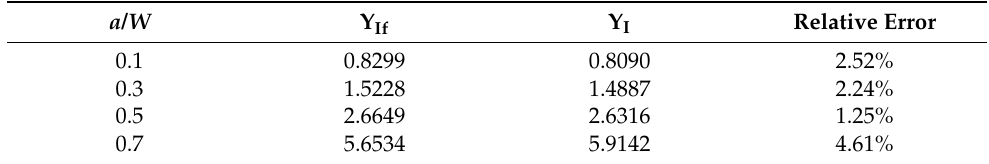
Table 3. Comparison between formula values and the numerical results of the dimensionless mode I SIF.